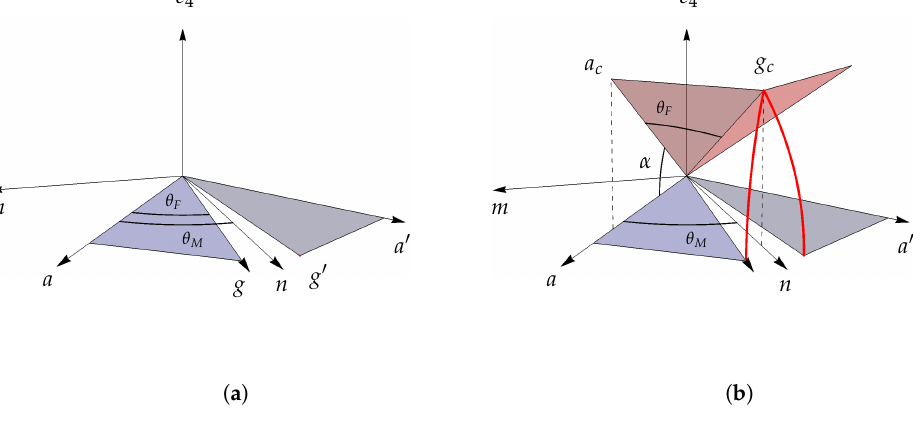
Figure 4. The discrete curvature transformation, shown in the 3-space of He 4 : ( a ) the initial configuration; and ( b ) both the initial and the final state. Shaded planar segments represent bivectors H and H (cid:48) before (blue) and after (red) the transformation. Vectors g and g (cid:48) rotate in planes parallel to ae 4 and a (cid:48) e 4 , respectively, until they meet in the ne 4 plane, perpendicular to m . Vector a also rotates up to a c , so θ F between a c and g c projects down to θ M between a and n